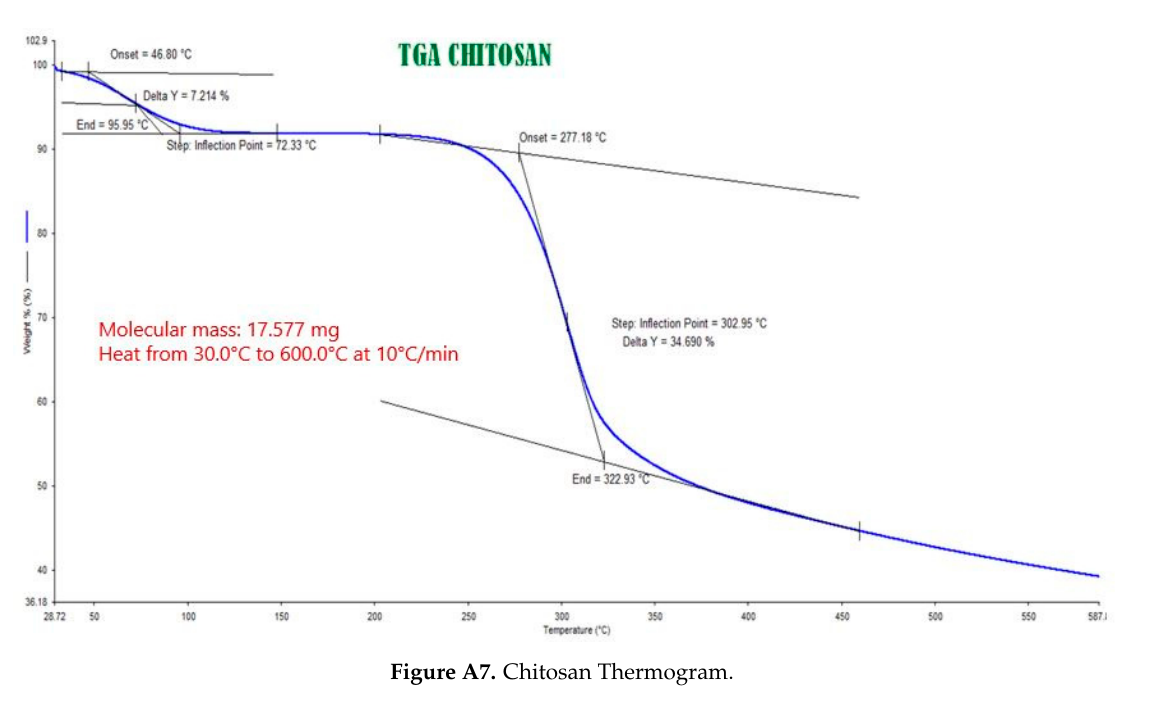
Figure A6. Erlotinib infrared spectra and formulation overlapping.